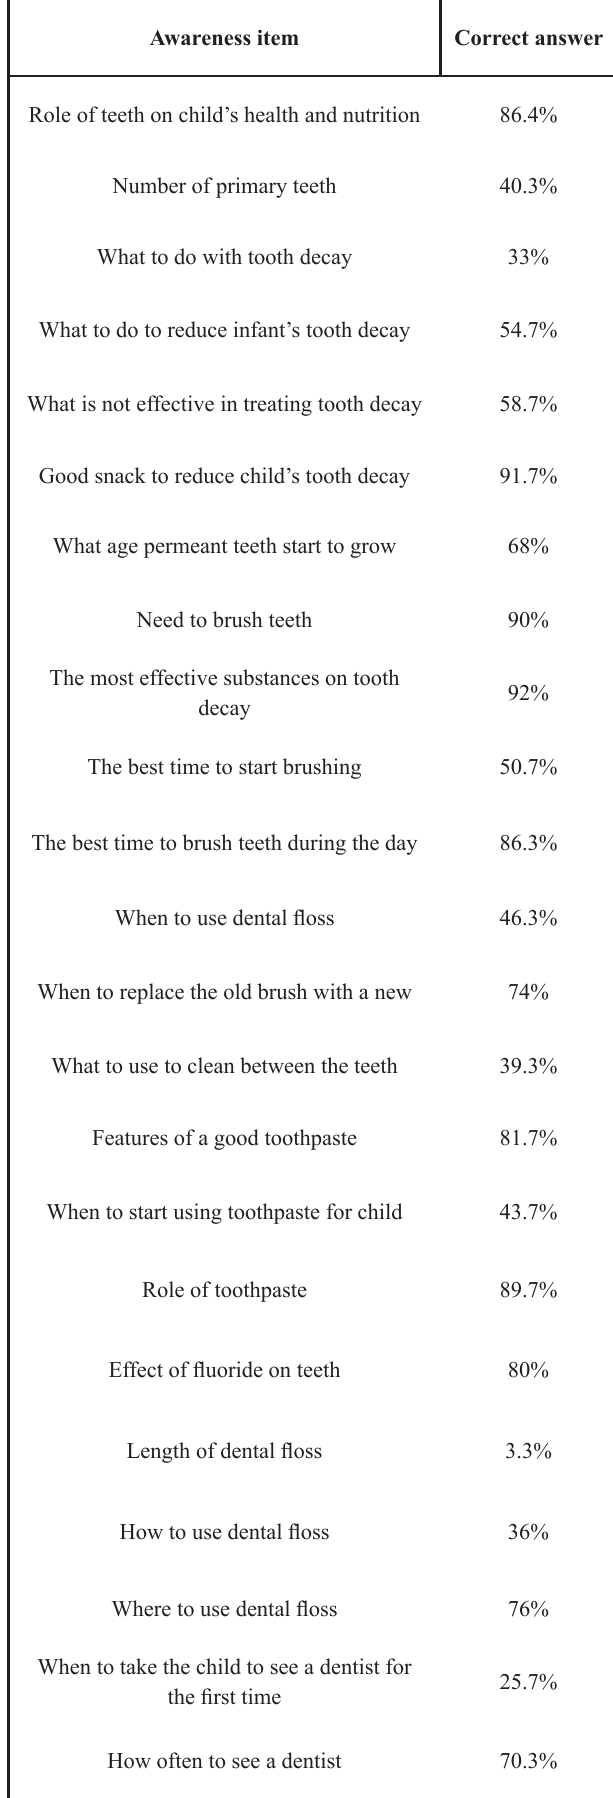
Table 2. Distribution of response to knowledge questions in mothers referring to health centers for the oral health of children aged